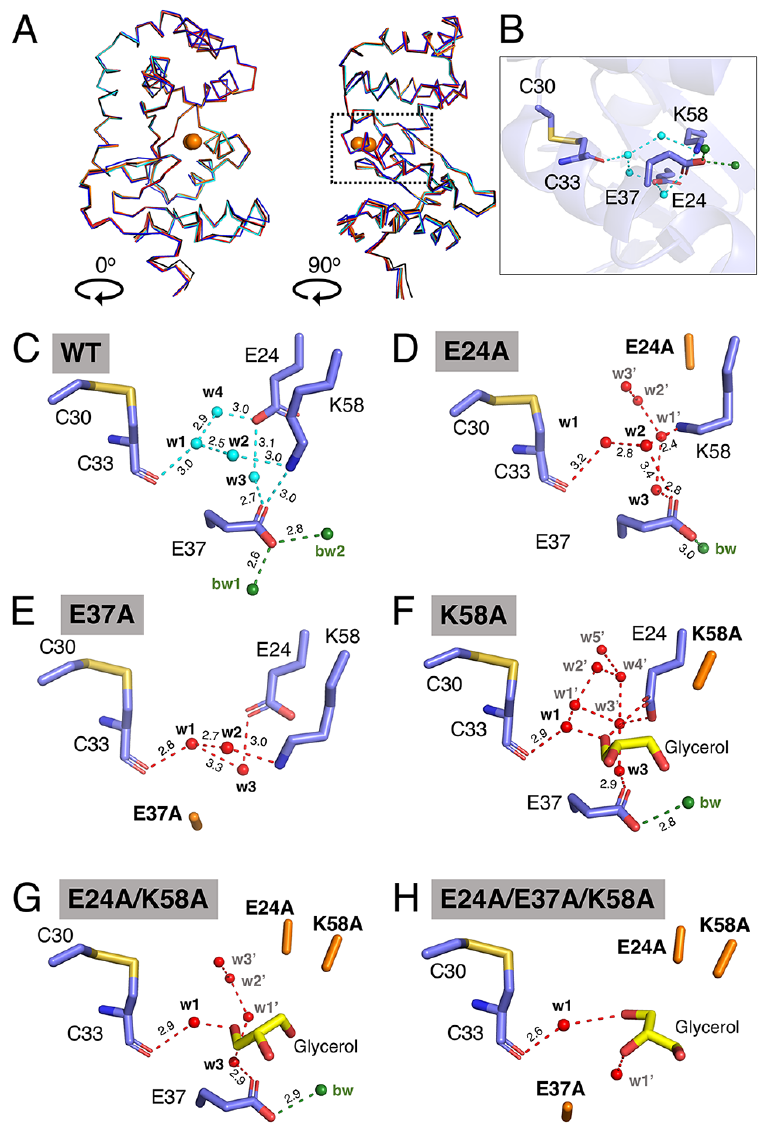
Figure 4. Structural characterisation of EcDsbA mutants by X-ray crystallography. ( A ) Structural overlay of EcDsbA wildtype (blue, PDB ID 5QO9), E24A (salmon), E37A (orange), K58A (cyan), E24A/K58A (red) and E24A/E37A/K58A (black). The overlaid structures are presented in two orthogonal orientations, labelled 0 ◦ and 90 ◦ . Active site cysteines are shown as orange spheres. A dashed box indicates the location of the expanded view of EcDsbA wildtype shown in ( B ). ( C – H ) Water network in buried water channel of EcDsbA wildtype, mutants E24A, E37A, K58A, E24A/K58A and E24A/E37A/K58A. Hydrogen bonds are shown as dashed lines and distances in Å are indicated. Water molecules are shown as cyan or red spheres and labelled. Bulk water (bw) is shown as green spheres.